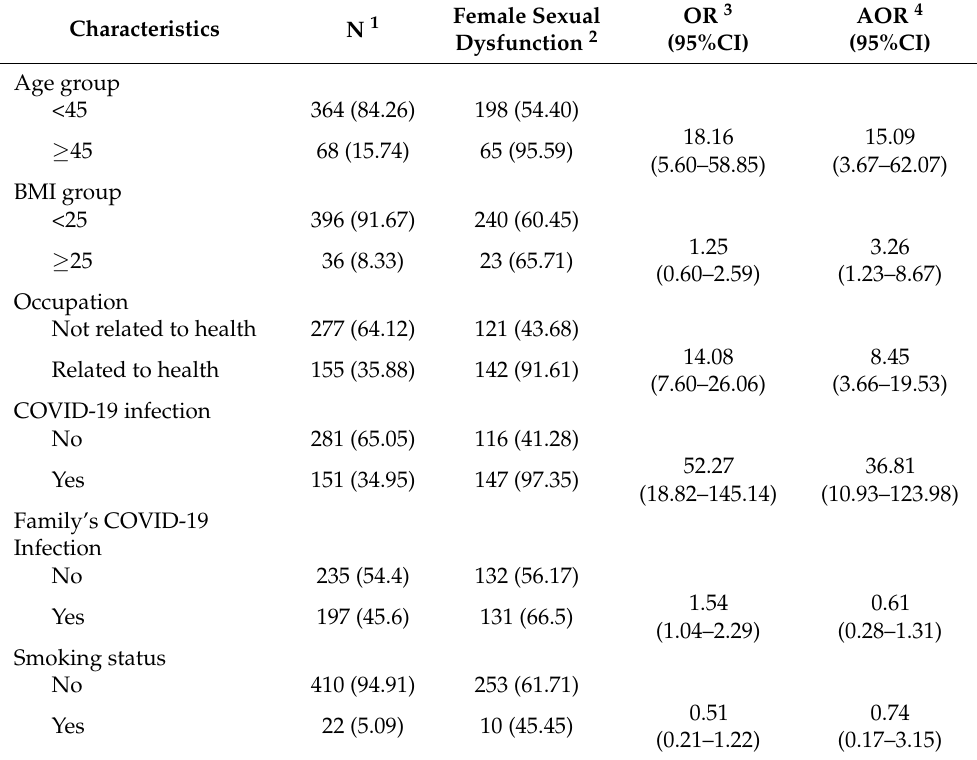
Table 5. Univariate and multivariate logistic regression analysis of factors influencing female sexual dysfunction ( n =